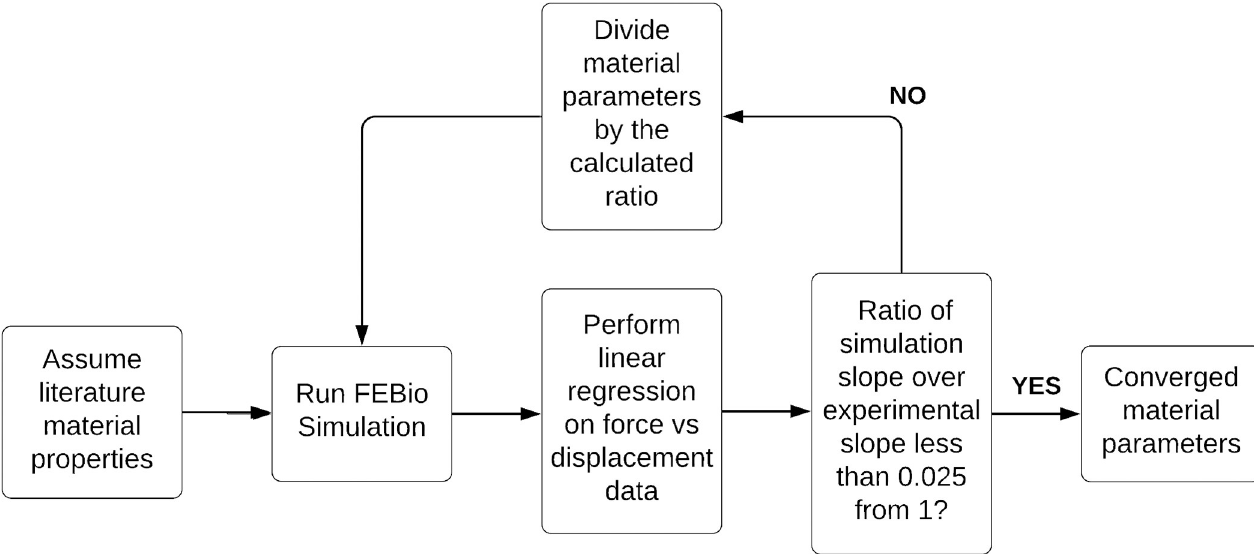
Fig 3. Flowchart of the optimization process. All models received the same initial guess. Simulations were repeated until there was less than a 2.5% difference between the linear regression fits.